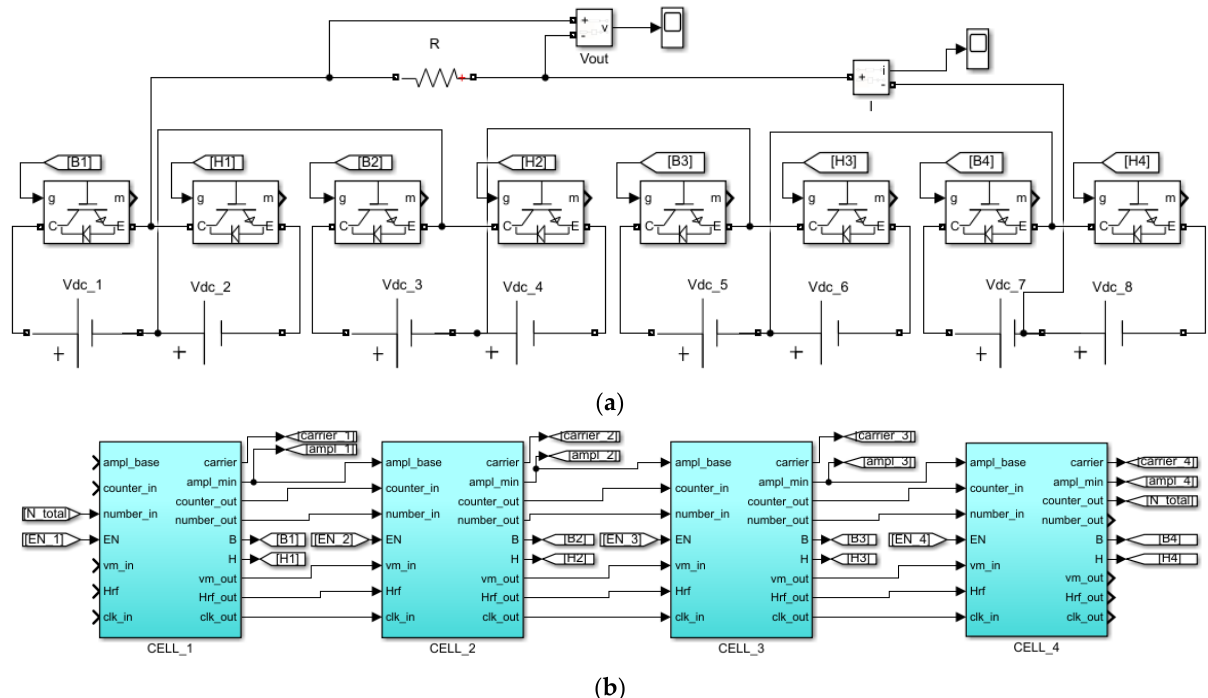
Figure 10. Simulation model of the multiphase DC/DC converter (four phases), ( a ) topology; ( b ) connection between each cell controller.